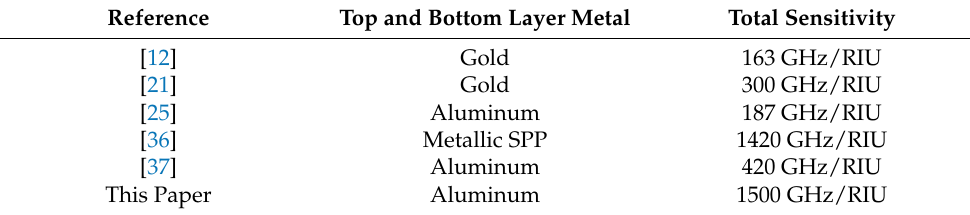
Table 5. Performance comparison of the proposed sensor in terms of material used and sensitivity.